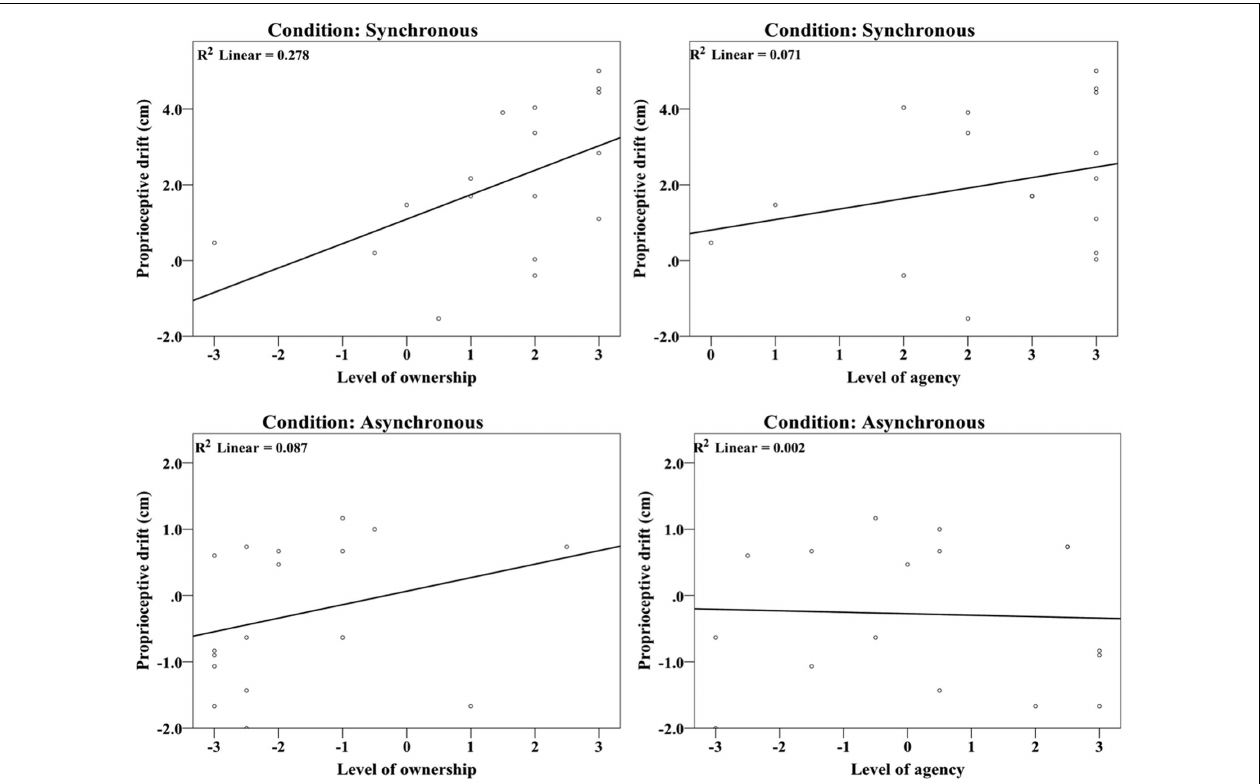
FIGURE 4 | Correlation analysis between proprioceptive drift and the ownership and agency ratings in the synchronous and asynchronous